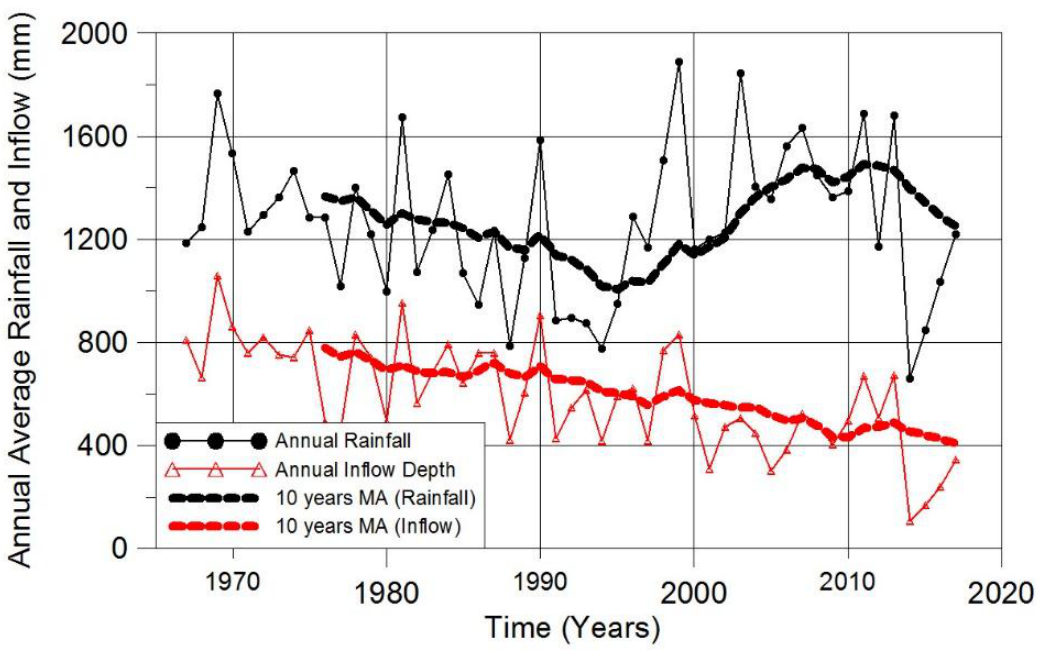
Figure 3. Annual average rainfall and inflow and moving average (MA) lines. Table 2. Statistical characteristics of the two collected data series.